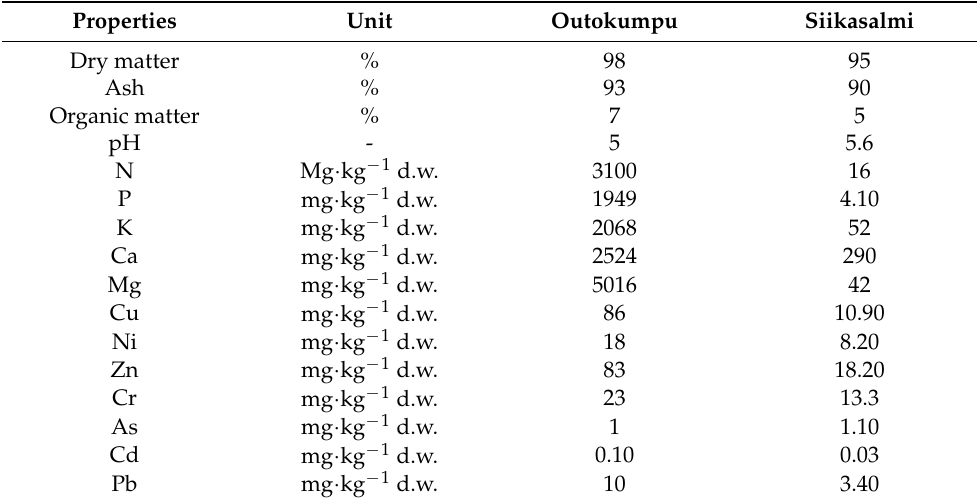
Table 5. The physicochemical properties of the Outokumpu and Siikasalmi field soil (n = 3). Properties Unit Outokumpu